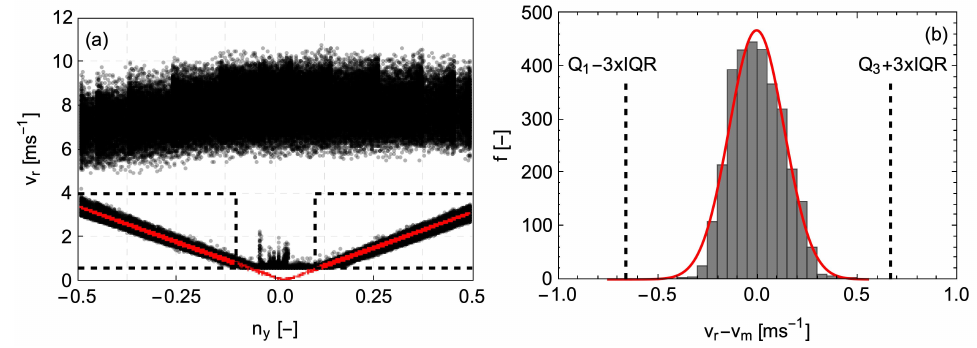
Figure 7. ( a ) Radial speed measurements versus the transverse component of the line-of-sight vector. The two horizontal dashed black lines depict the two velocity limits 0.6 ms − 1 and 4 ms − 1 used to select radial speed values that are attributed to the rotating blades. The modelling of the radial speed due to the blade and the subsequent determination of the SpinnerLidar position was applied only for | 𝑛 𝑦 | > 0.1 (depicted with two vertical dashed black lines). ( b ) Histogram of the differences between the measured 𝑣 𝑟 and the modelled 𝑣 𝑚 radial speeds using Equation (7) for the data that was acquired when 0.2 < 𝑛 𝑦 <